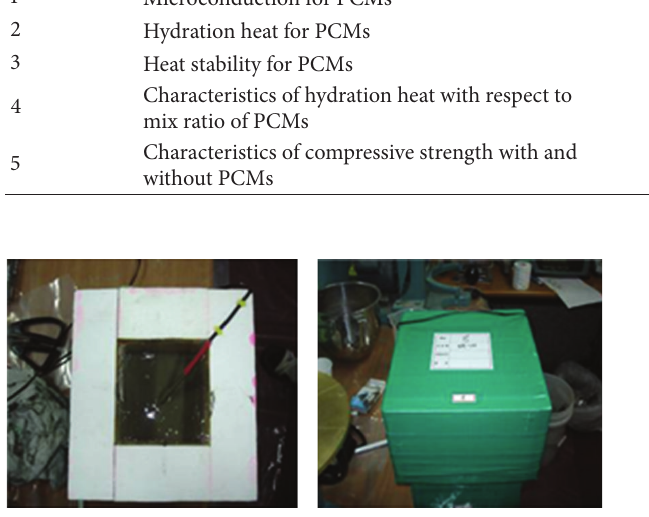
Figure 1: Semiadiabatic temperature rise test setup.